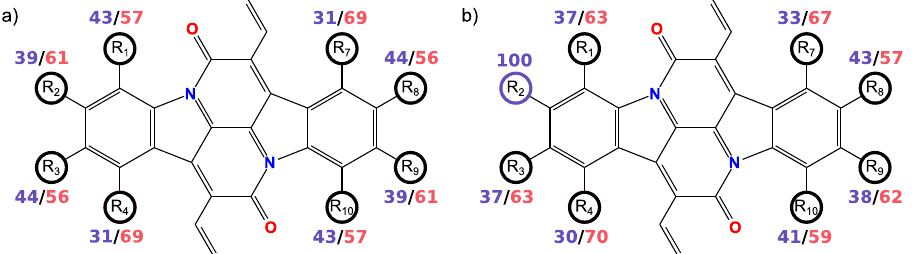
Fig. 9 Structural occurrences of electron withdrawing and donating groups. a Probabilities of fi nding an electron withdrawing (blue left number) and donating group (red right number) at each position of the 393,841 predicted SF-PV candidates. b Conditional probabilities for encountering a second group, after an electron withdrawing group has been chosen for position R 2 . The substituents were assigned to the respective groups in accordance with the colour scheme of Fig.